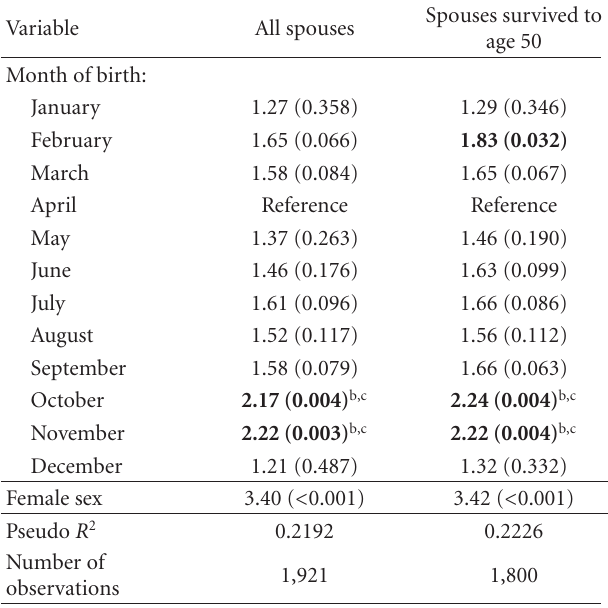
Table 7: Odds ratios ( P values) to become a centenarian as pre- dicted by conditional logistic regression (fixed e ff ects), by di ff erent age cut-o ff and gender subgroups for spouses of